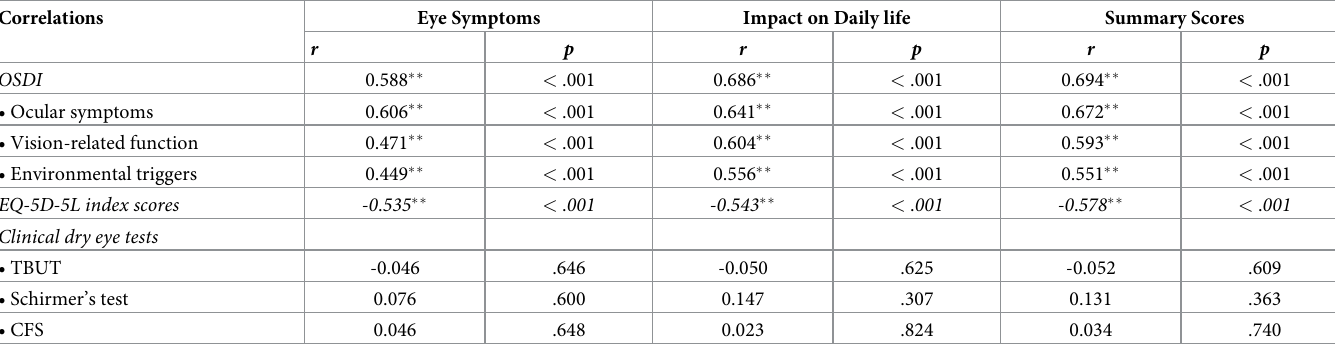
Table 5. Correlation between DEQS-Th, OSDI, index score of EQ-5D, and clinical tests among DED patients. Correlations